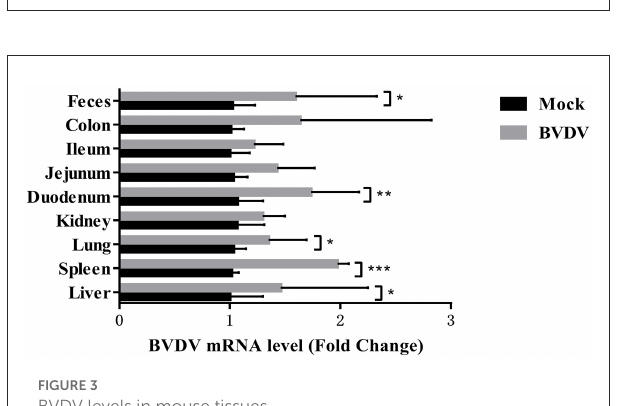
FIGURE3 BVDV levels in mouse